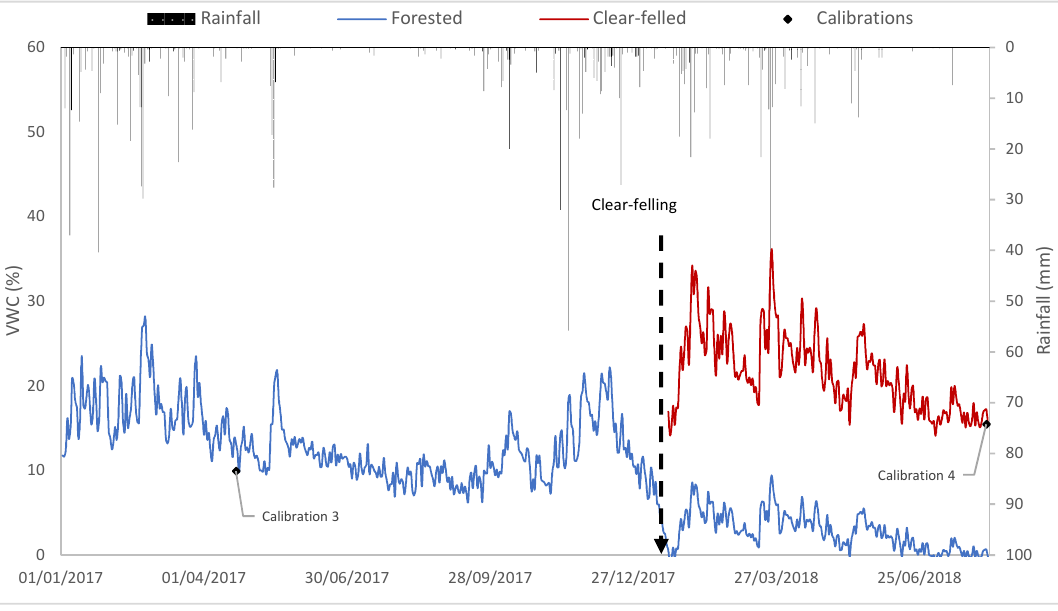
Figure 4. Time series of daily CRNS soil water content estimates using the “forested” and “clear-felled” calibration values from January 2017 to August 2018 in the Acacia mearnsii plantation in the Two-Streams Catchment.